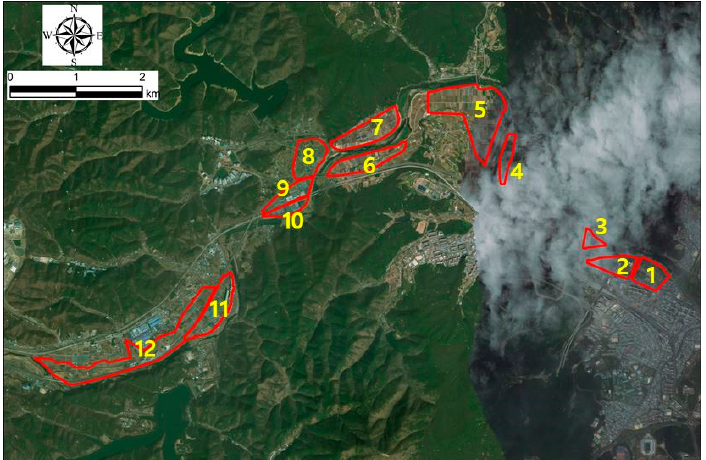
Figure 12. Location of selected flood-prone areas. The performance of the real-time flood prediction method proposed in this study was tested by applying scenario rainfall and actual typhoon event. The flood extent from FLO-2D, a physical numerical model, and the one from flood probability discriminant was expressed as simulation and prediction, respectively. The upstream boundary condition of the FLO-2D for the scenario rainfall of No. 92 (Table 1) is shown in Figure 13, and the open condition was applied as the downstream boundary condition. The maximum flood extents of simulation and prediction for scenario No. 92 were represented by red checkered areas and hollow yellow solid lines, respectively, as shown in Figure 14. For quantitative comparison between simulation and prediction, the goodness of fit (G) was calculated by Equation (6). The goodness of fit of the flood extent between the two by scenario rainfall was relatively well-matched with 83.6~98.4%, as shown in Table 3.